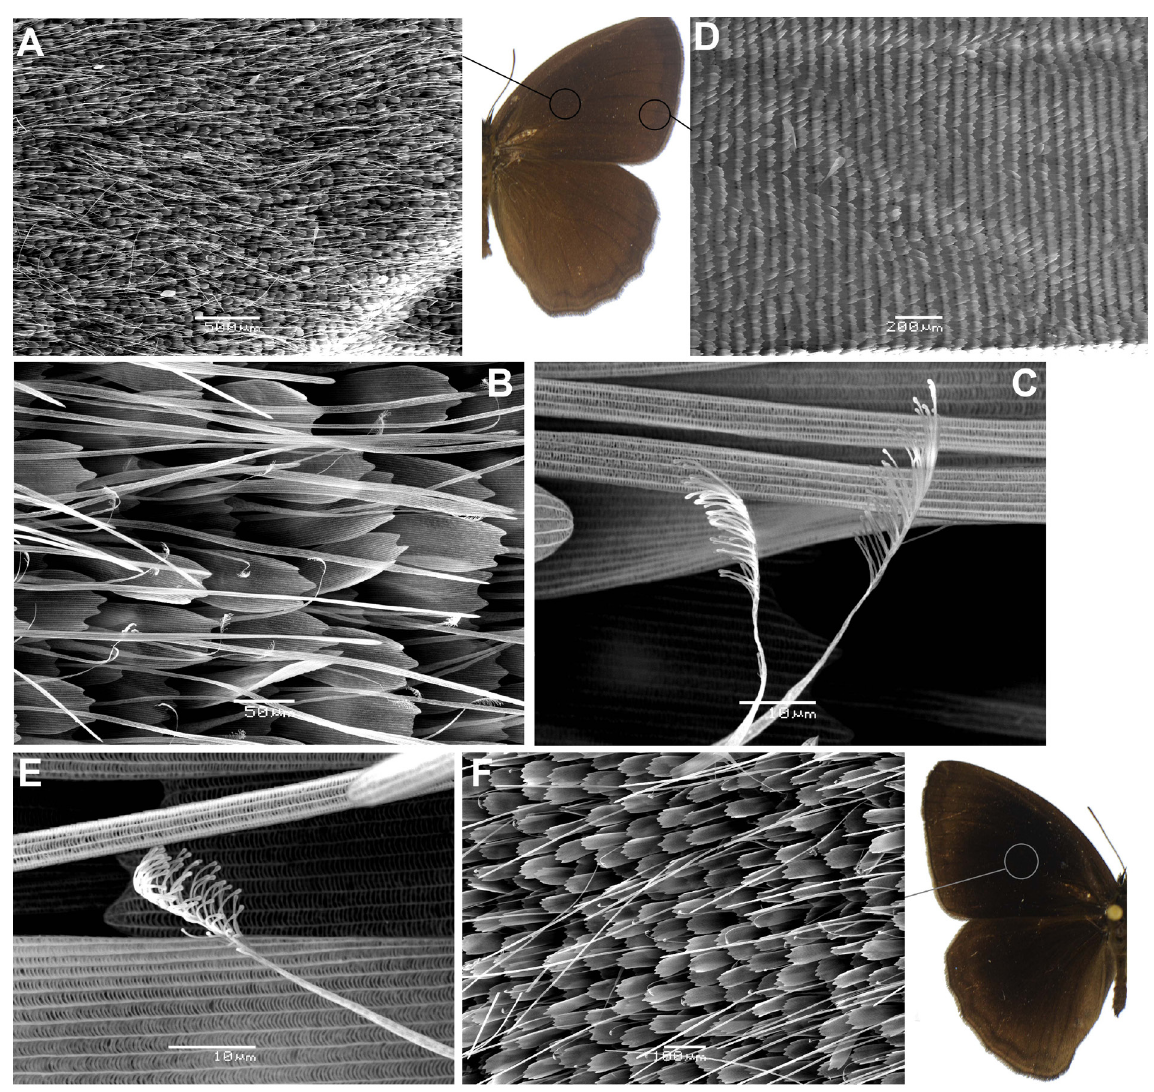
Fig. 12. Wing scales of Zischkaia Forster, 1964. A–C . Images of forewing androconial scales of Z. pacarus (Godart, [1824]), showing the presence of plumose androconial scales. D . Typical wing scales of Z. pacarus . E–F . Images of forewing androconial scales of Z. chullachaki Nakahara & Zacca, sp. nov., showing the presence of plumose androconial